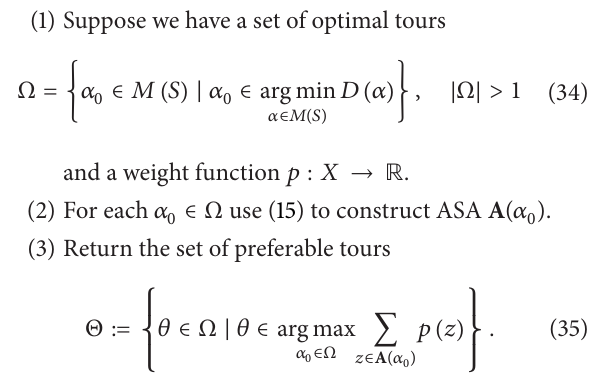
Algorithm 2 (selection among equally optimal TSP